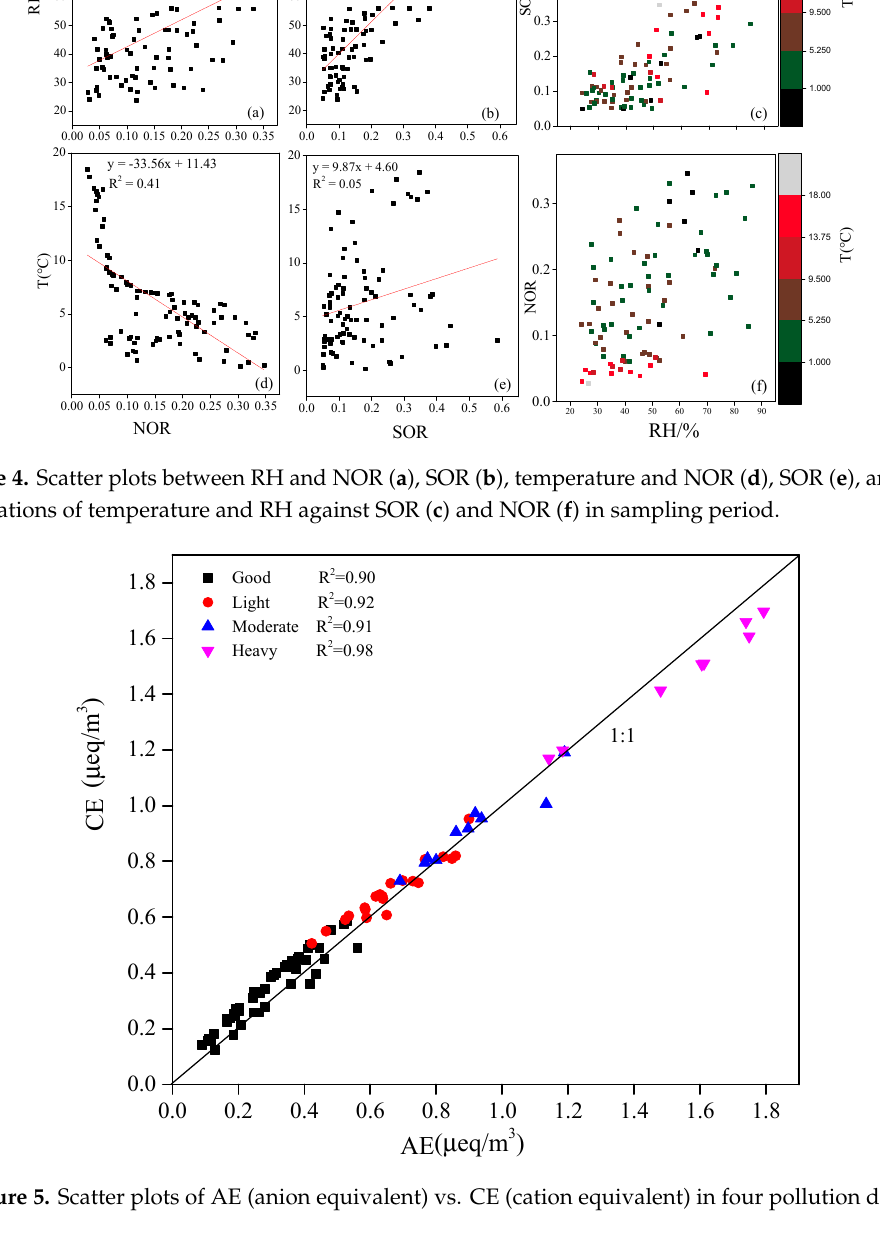
Figure 5. Scatter plots of AE (anion equivalent) vs . CE (cation equivalent) in four pollution days.